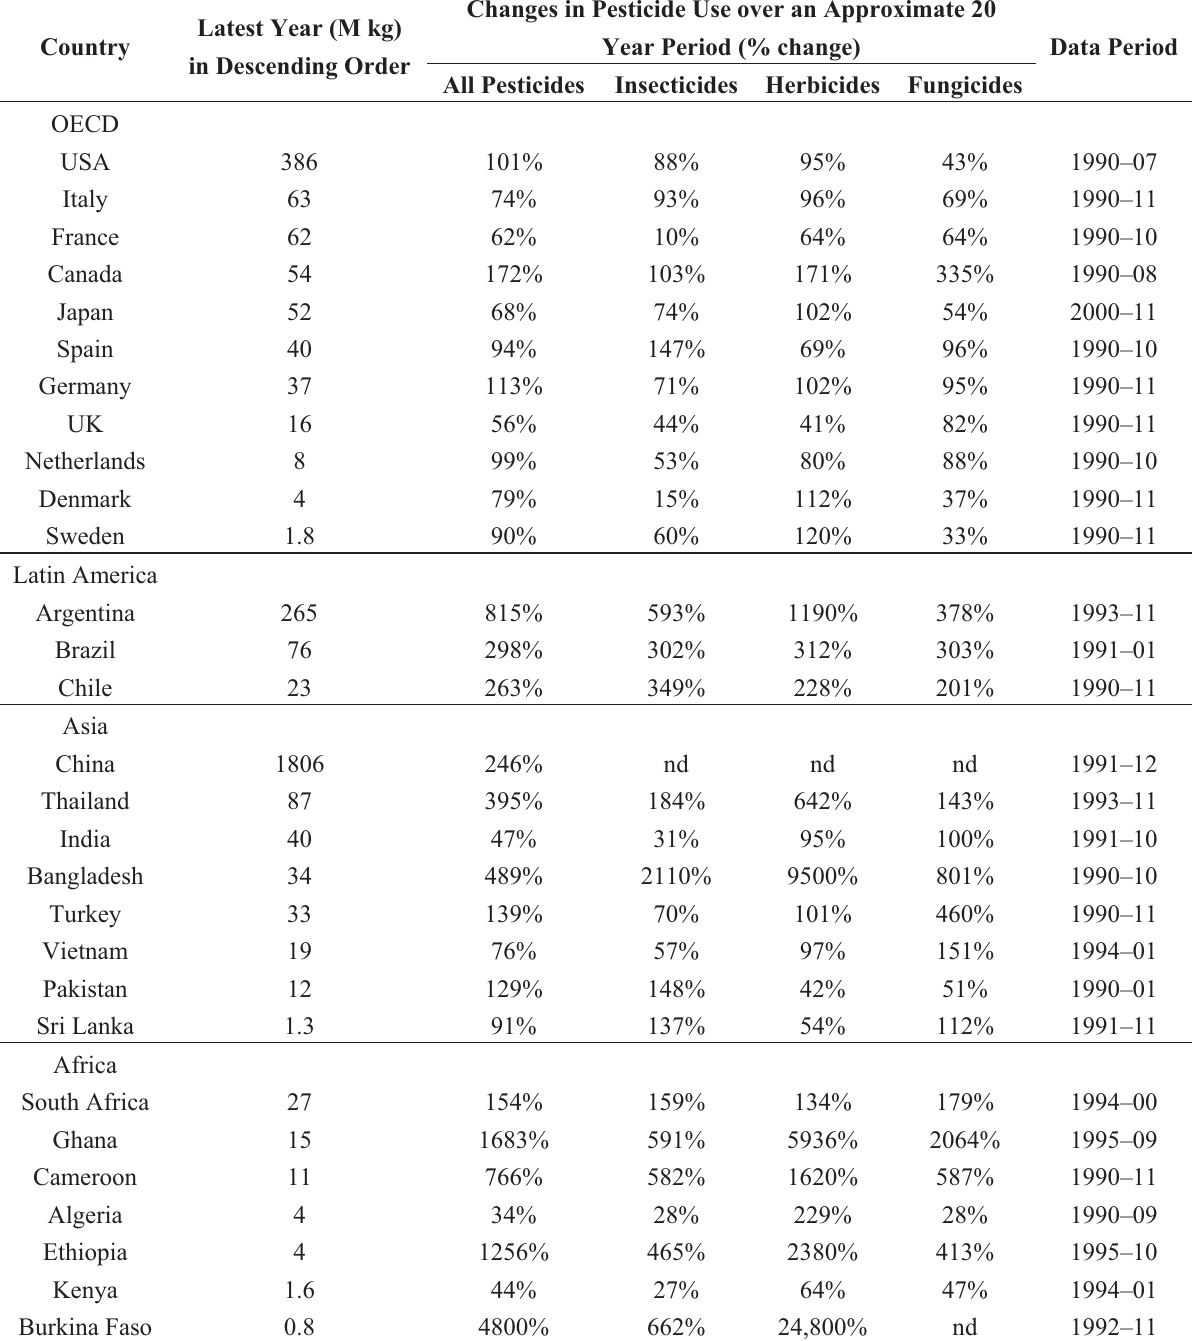
Table 1. Country level agricultural pesticide use (1990 to latest data: 2007 – 2012).